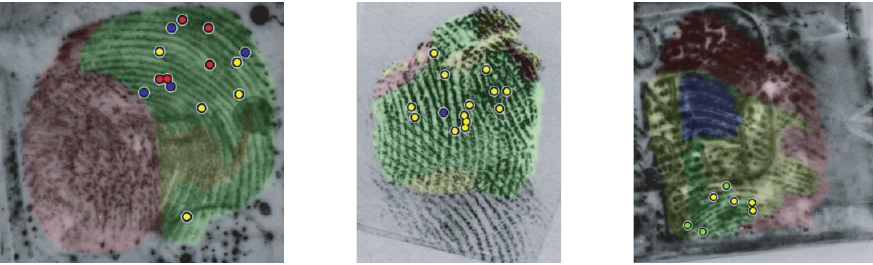
Figure 2. Example markups of latent fingerprints taken from Ulery et al. [27]. On each latent fingerprint image, the retained minutiae are in yellow, moved in blue, deleted in red, and added in